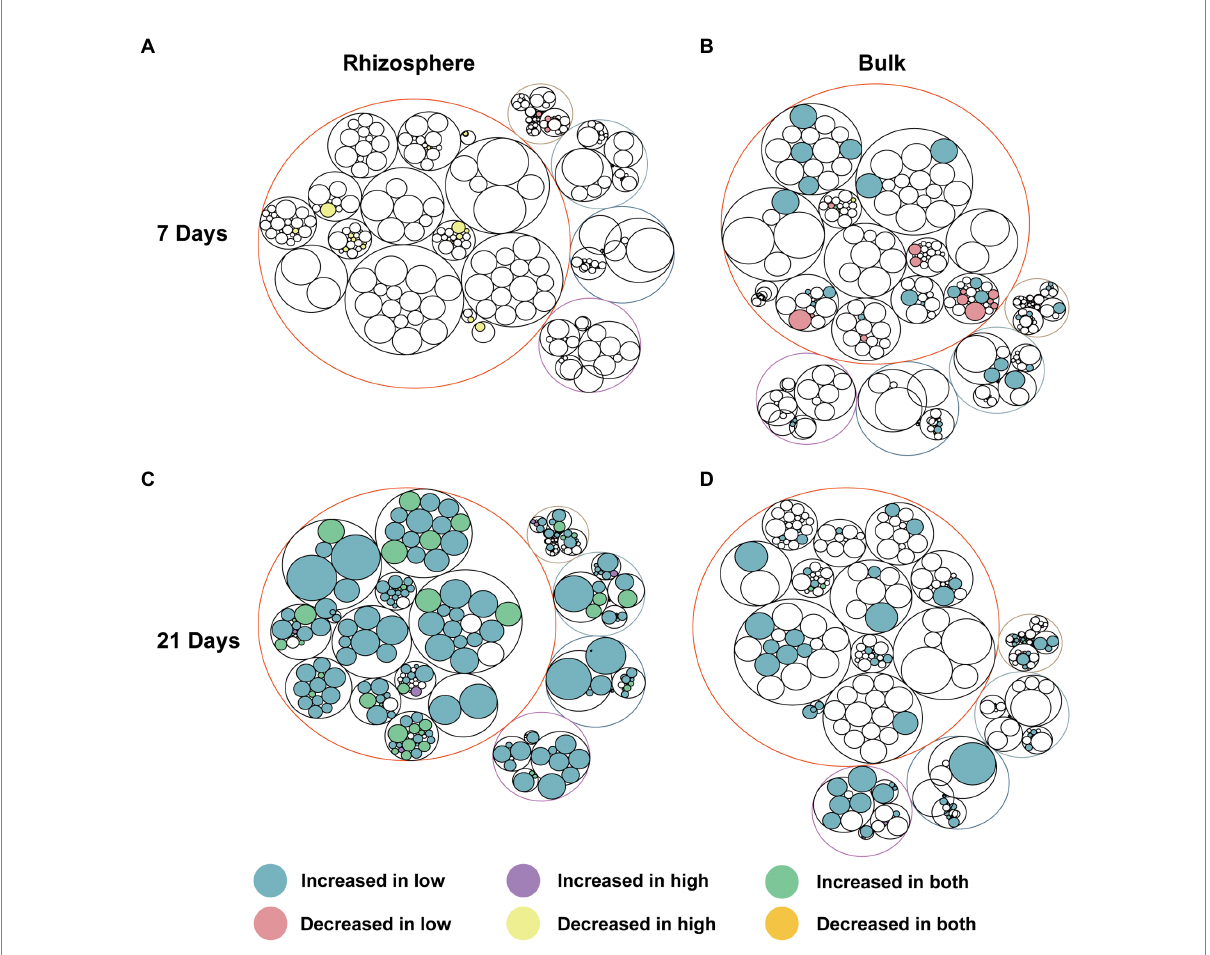
FIGURE 4 Functional pathways of the microbial communities altered after abamectin treatments. The different colors of the outermost layer represented different categories of metabolic pathway functions. The outermost circles represent the pathways at the KEGG level 1, the deepest circles represent the functional pathways at KEGG level 3. Pathways showing significant difference ( p < 0.05) between the control and abamectin treatments are the legends showed. Circle size represents the average relative abundance of pathways in all samples. (A,C) Represent the functional pathways in rhizosphere at the 7 and 21 days. (B,D) Represent the functional pathways in bulk at the 7 and 21